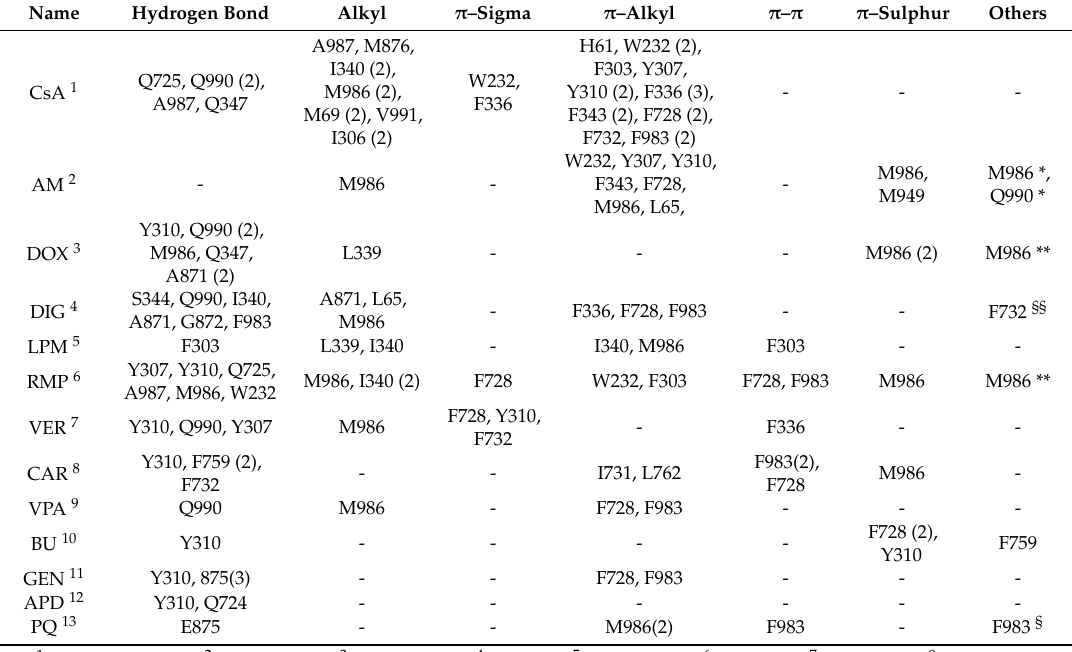
Table 15. Ligand–P-gp interaction types and amino acid residues involved in the binding of some well-known substrates and inhibitors of P-gp using the experimentally solved cryoEM structure of h P-gp (PDB ID: 6QEX). The numbers in parenthesis indicate the number of interactions in which the residue is